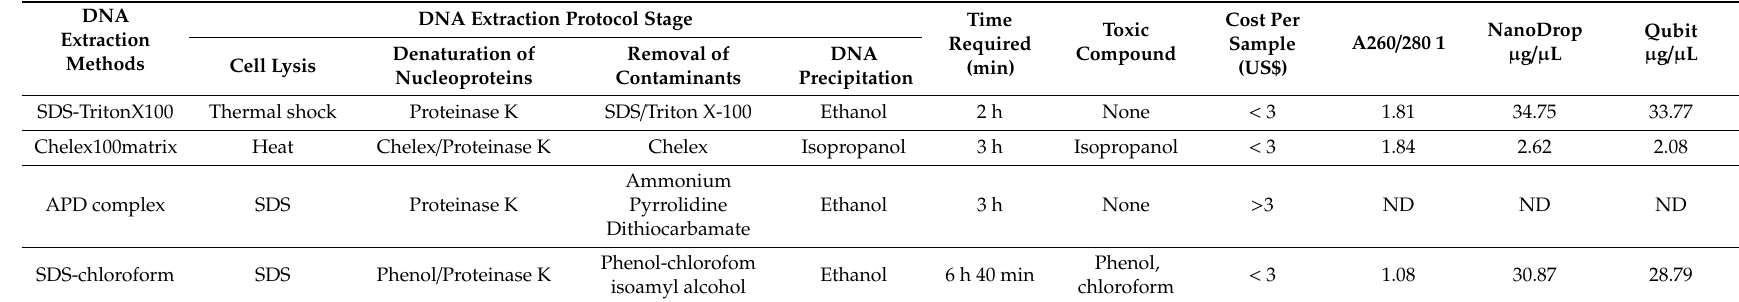
Table 2. Summary of results from comparative study of DNA extraction